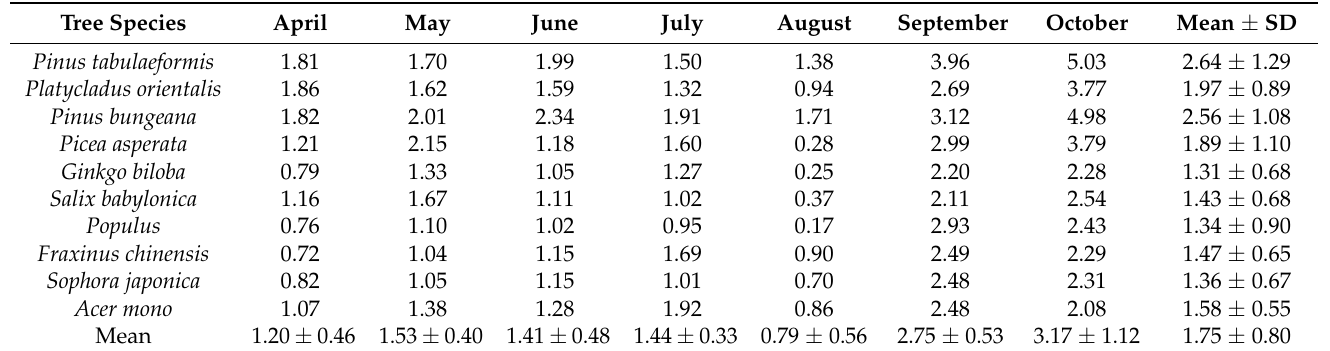
Table 2. PM 10 dust-retention capacity of leaves of different tree species ( µ g · cm − 2 ). Tree